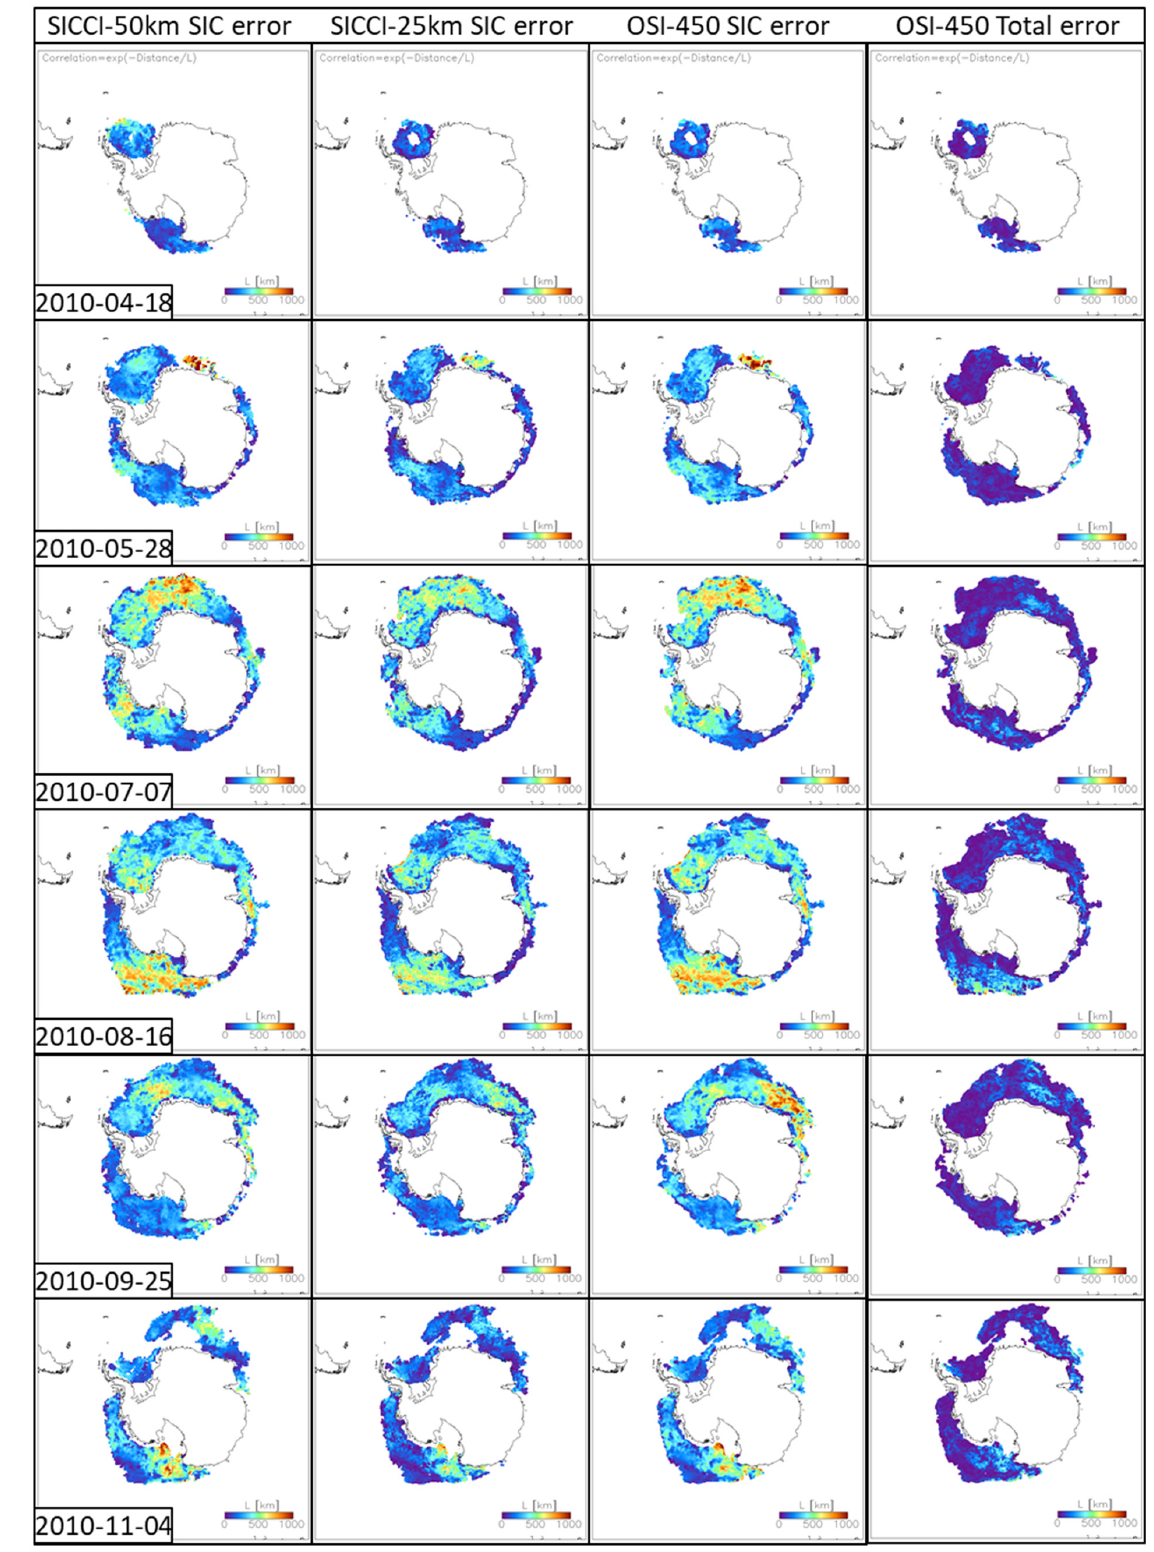
Figure 7. As Figure 6, but showing the correlation length scale in the Southern Ocean. Here, maps in months December, January and March are missing, while those falling into Austral winter (July, August, September) are all shown. Differences in the spatial extent of valid values, e.g., on 2010-09-25, are caused by the methodological requirements such as the need for a SIC larger than